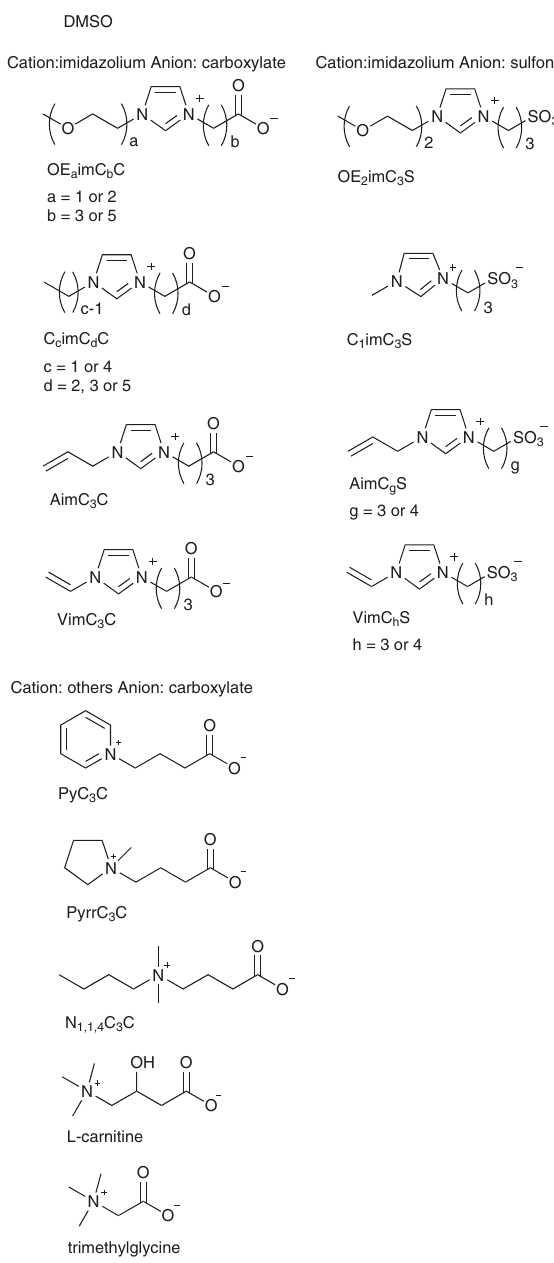
Fig. 1 Structures of DMSO and the zwitterions used in this study. They are categorized by the cation and anion